Question: In one sentence, what is this figure communicating?
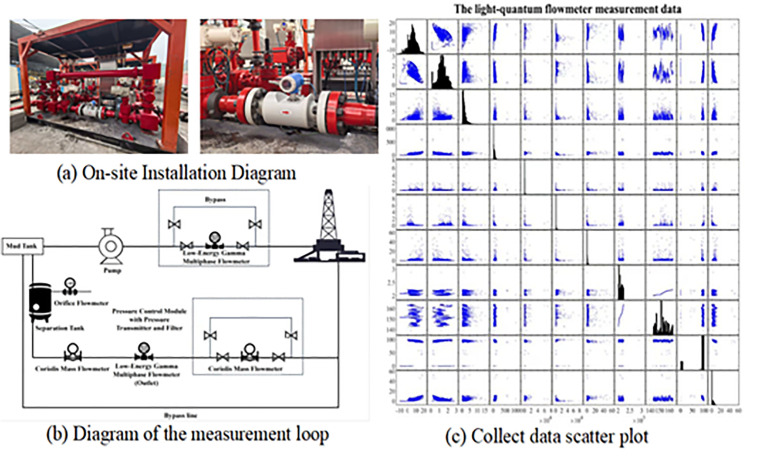
Answer: On-site experimental equipment and data scatter plot.